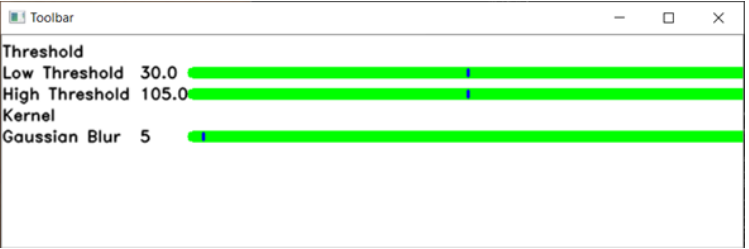
Figure 5. Image of toolbar.